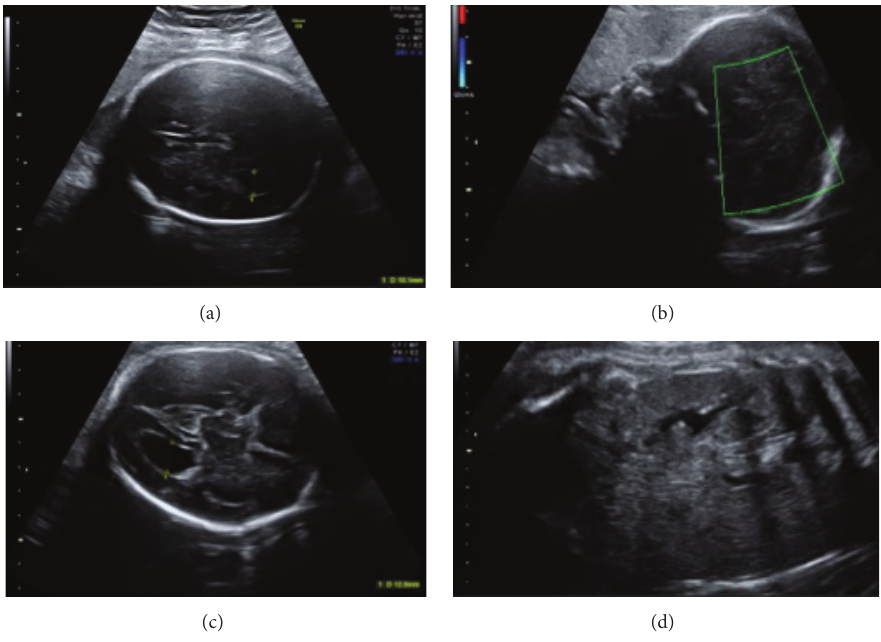
Figure 1: Ultrasound images of absent corpus callosum, mild ventriculomegaly, and enlarged kidney. (a) US image of absent cavum septum pellucidum. (b) US image of absent corpus callosum. (c) US image of ventriculomegaly. (d) US image of enlarged